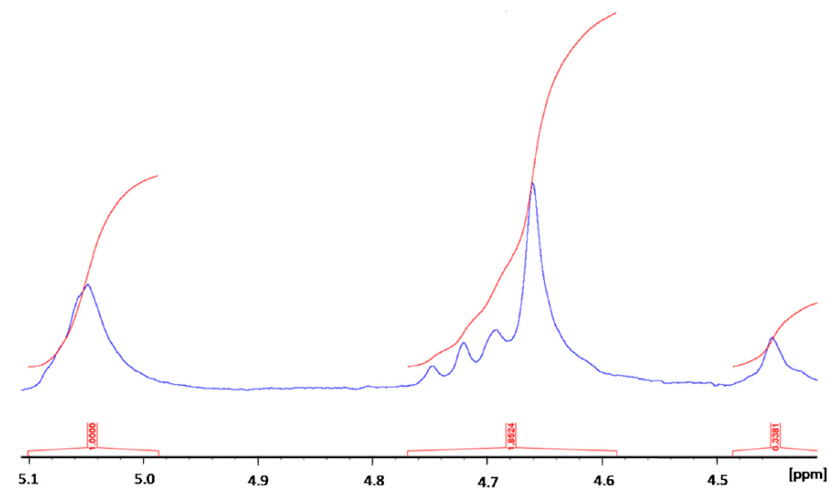
Gels 2022 , 8 , x FOR PEER REVIEW